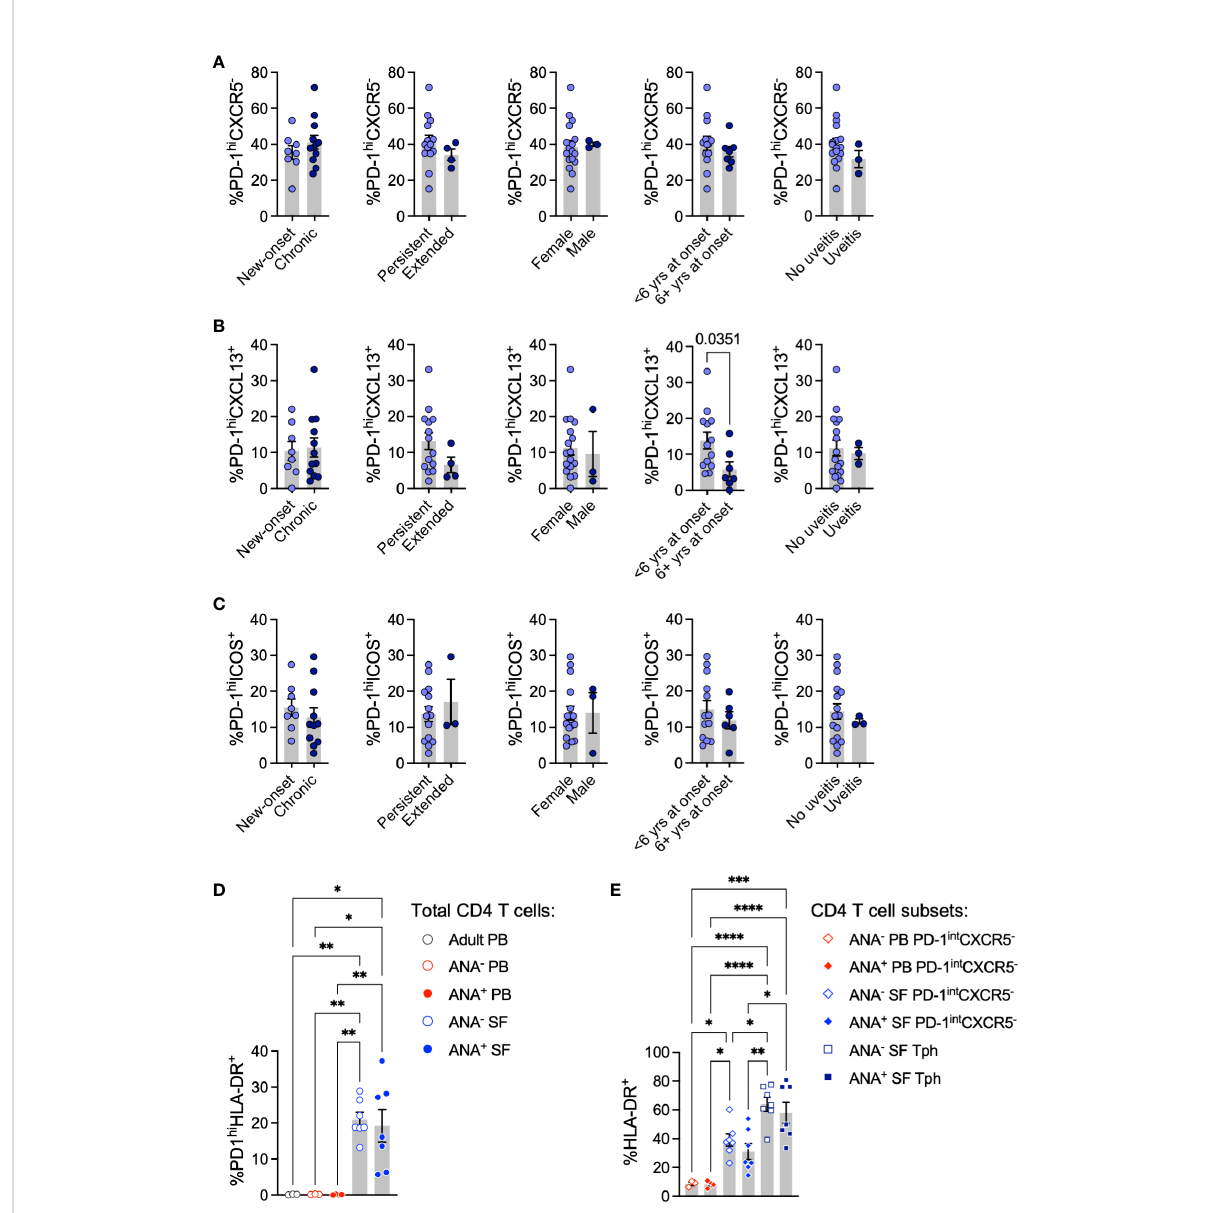
FIGURE 2 T peripheral helper cells in oligo JIA patients contrasted by disease characteristics. (A-C) Percent of Tph (CD4 + PD-1 hi CXCR5 - , panel A), PD-1 hi CXCL13 + (panel B), and PD-1 hi ICOS + (C) cells among total CD4 + T cells in the SF of oligo JIA patients (n=20) with varied disease characteristics. (D) Percent of PD-1 hi HLA-DR + cells among CD4 + T cells in the SF of oligo JIA patients (ANA - : n=7, ANA + : n=7, blue circles), and in the PB of oligo JIA patients (ANA - : n=3, ANA + : n=4, red circles) and adult controls (n=3, black circle). (E) Percent of HLA-DR + cells among CD4 + PD-1 int CXCR5 - and Tph subsets in the SF (ANA - : n=7, ANA + : n=7) and in the PB (ANA - : n=3, ANA + : n=4) of oligo JIA patients. yrs, years; PB, peripheral blood; SF, synovial fl uid; ANA, antinuclear autoantibody; Tph, T peripheral helper. Summary data on bar graphs are mean ± standard error. P-value <0.05 (*); <0.01 (**), <0.001 (***), <0.0001 (****). Statistical testing: (A-C) Two-tailed Student ’ s T-test; (D-E) one-way ANOVA followed by multiple t-tests with Turkey